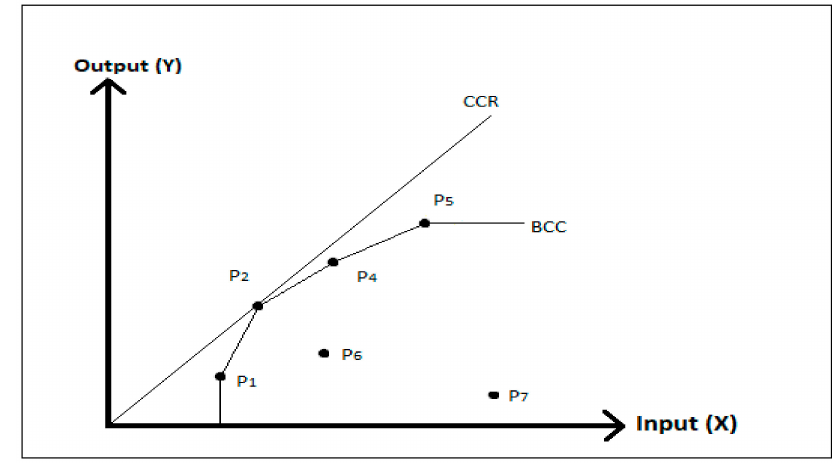
Figure 1. E ffi ciency frontiers based on CCR and BCC